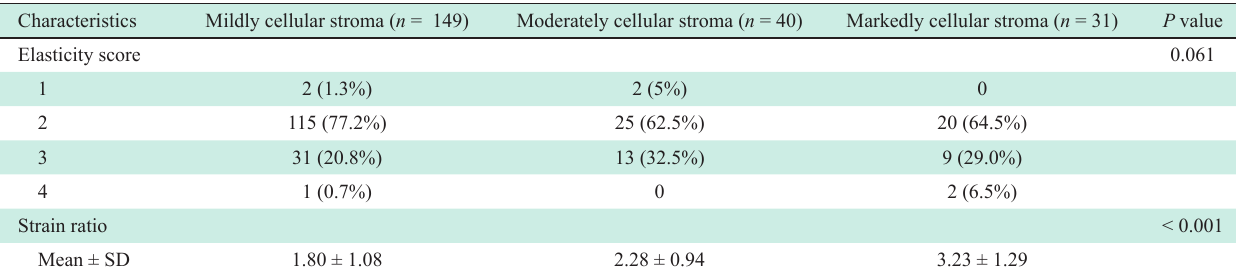
Table 3 Characteristics of strain elastography parameter according to stromal cellularity